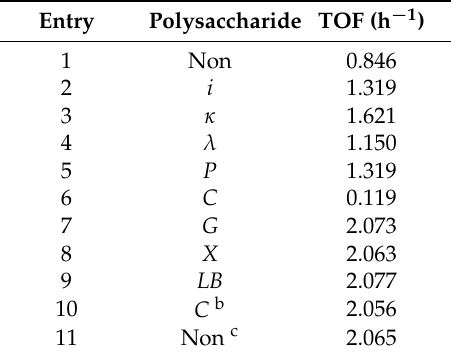
Table 2. Suzuki cross-coupling in the presence of PdCl 2 (TPPTS) 2 , supported on various polysaccharides a . Entry Polysaccharide TOF (h − 1 ) 1 Non 0.846